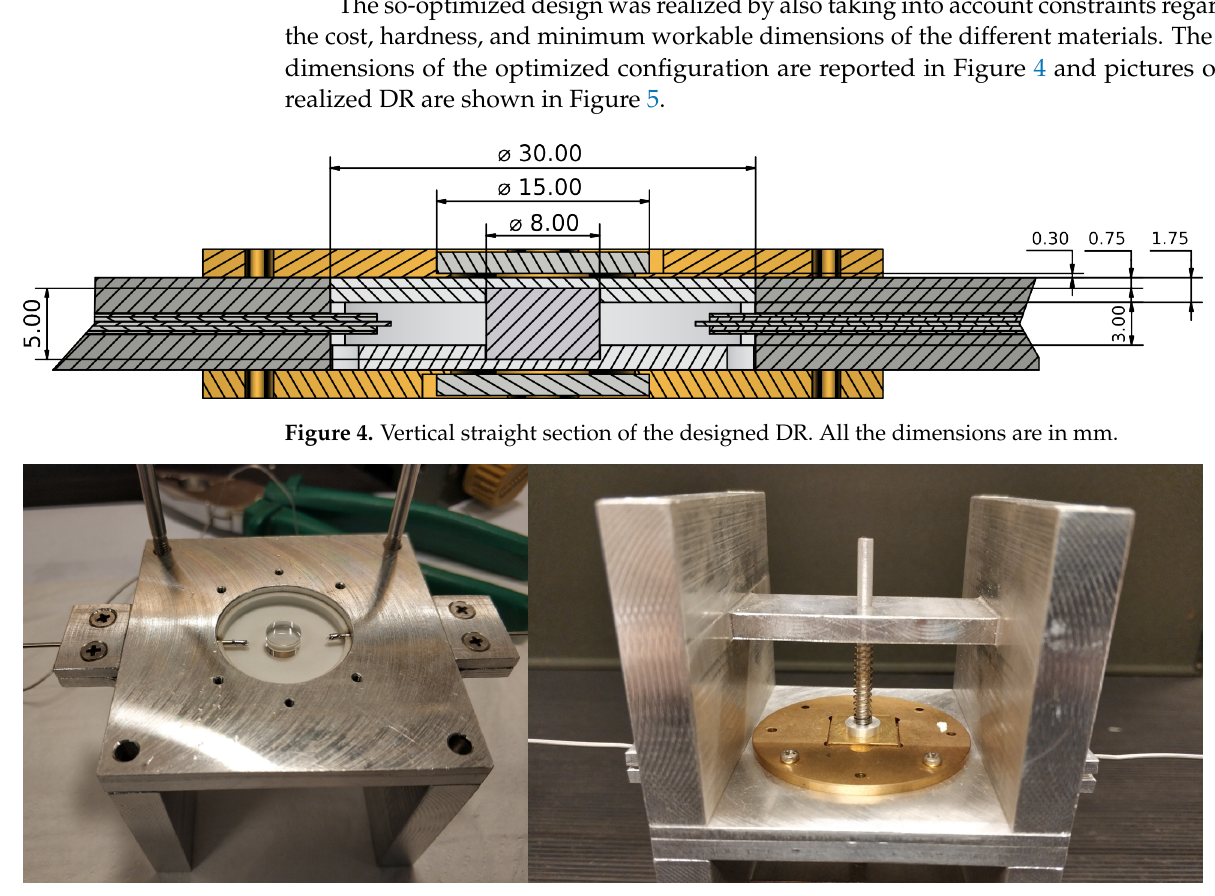
Figure 5. Pictures of the realized DR. On the left, the open cavity with the sapphire crystal. On the right, the closed DR with the external supporting